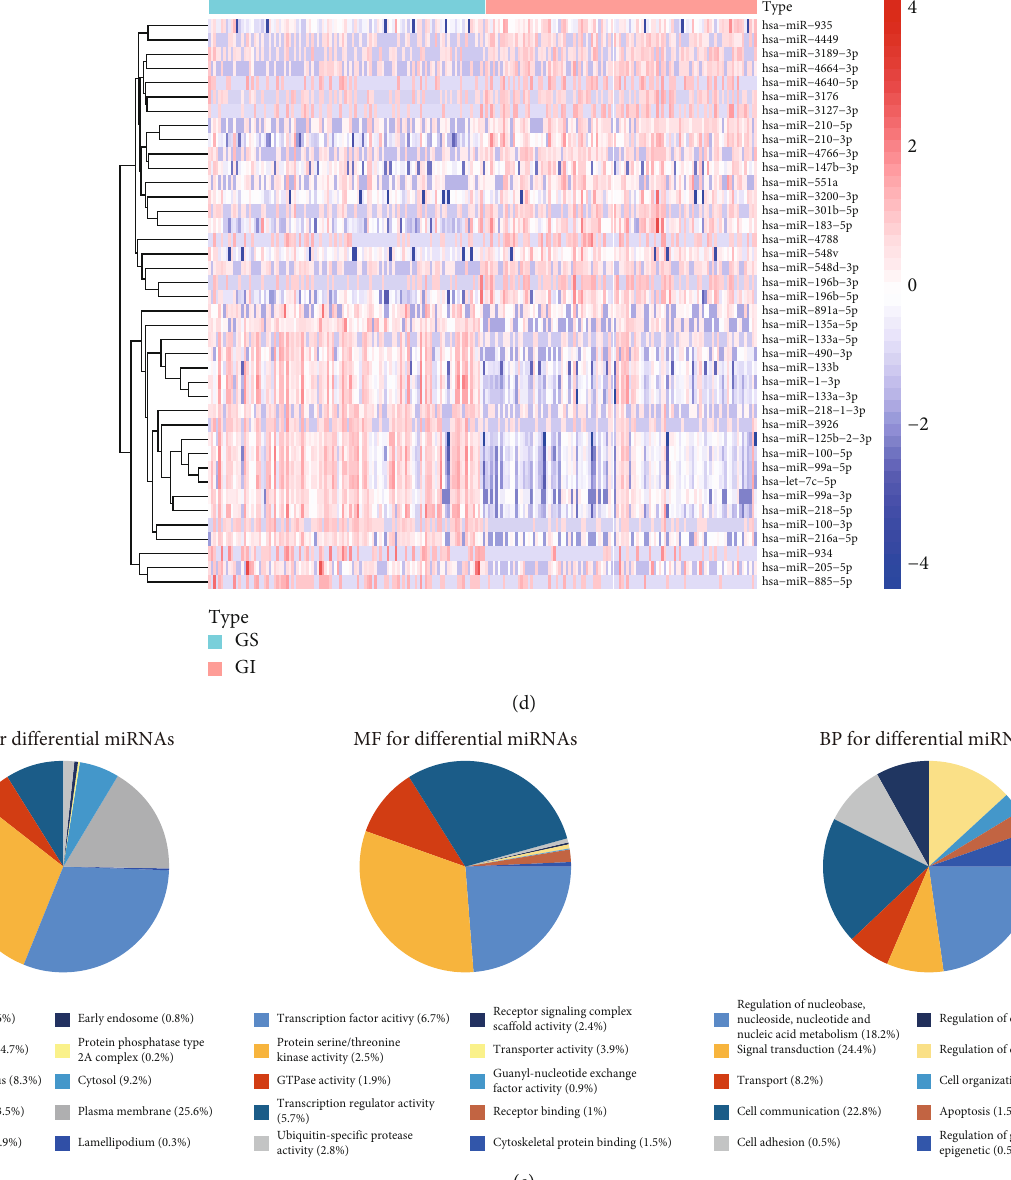
Figure 1: Identi fi cation of genomic features in the GS and GI groups. (a) Clustering heatmap of GS and GI patients based on di ff erentially expressed miRNAs. The left part (red) represents the GI patients and the right part (green) represents the GS patients. (b) Somatic mutation count and (c) UBQLN4 expression were signi fi cantly elevated in the GI patients compared to the GS patients. The blue dots indicate GS patients, and the red dots indicate GI patients. (d) Heatmap of the top 40 di ff erential miRNAs between GS and GI groups. The red represents the GI patients, and the green represents the GS patients. (e) GO analysis of di ff erential